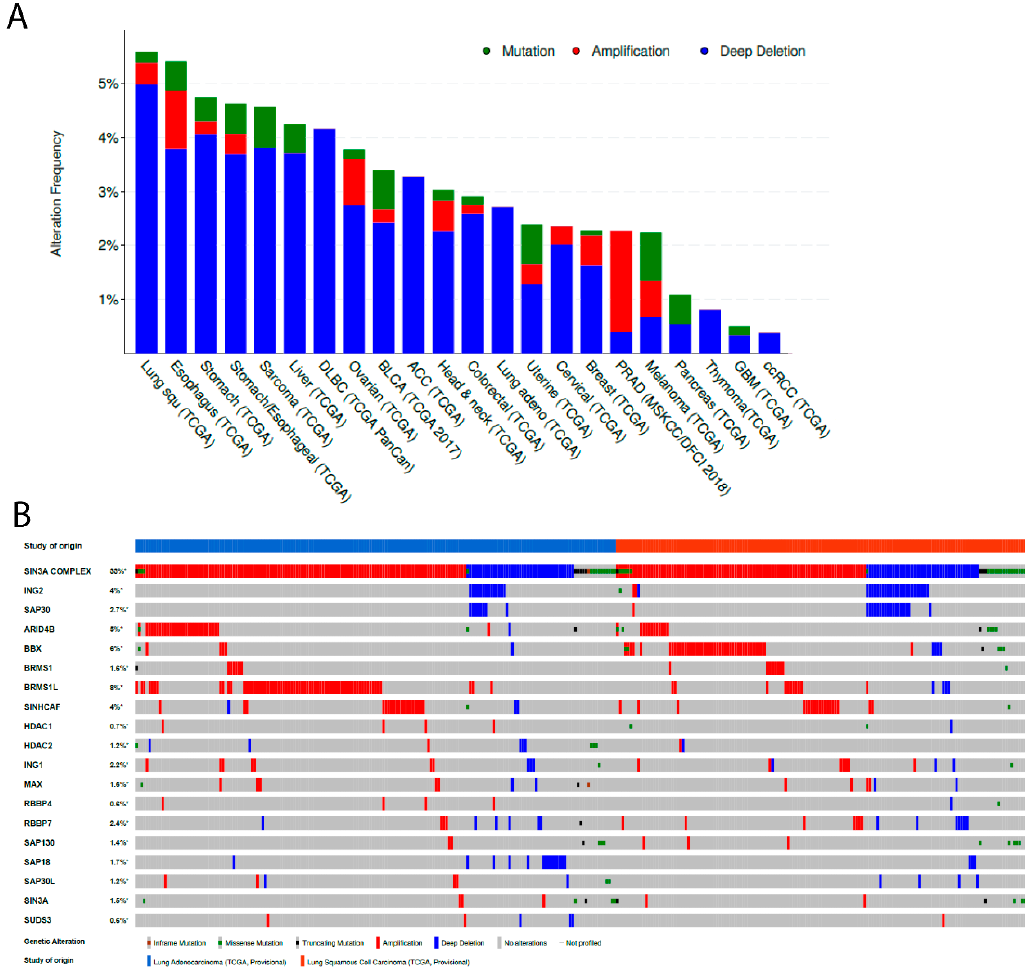
Figure 2. Despite ING2 being rarely altered at the genomic level in cancers, genomic alteration of at least one member of the mSin3A/HDAC complex is frequent. ( A ) Bar graph showing the alteration frequency according to pathology (from the TCGA database). Blue represents gene deletion, red represents gene amplification, and green represents gene mutation. ( B ) Heatmap representing genomic alterations of mSin3A/HDAC members, according to NSCLC subtype (adenocarcinoma or squamous cell carcinoma) (from the TCGA database). First line is a pool of all mSin3A/HDAC member genomic alterations. Of note, specimens without any genomic alteration concerning the mSin3A/HDAC members are not depicted in the figure.